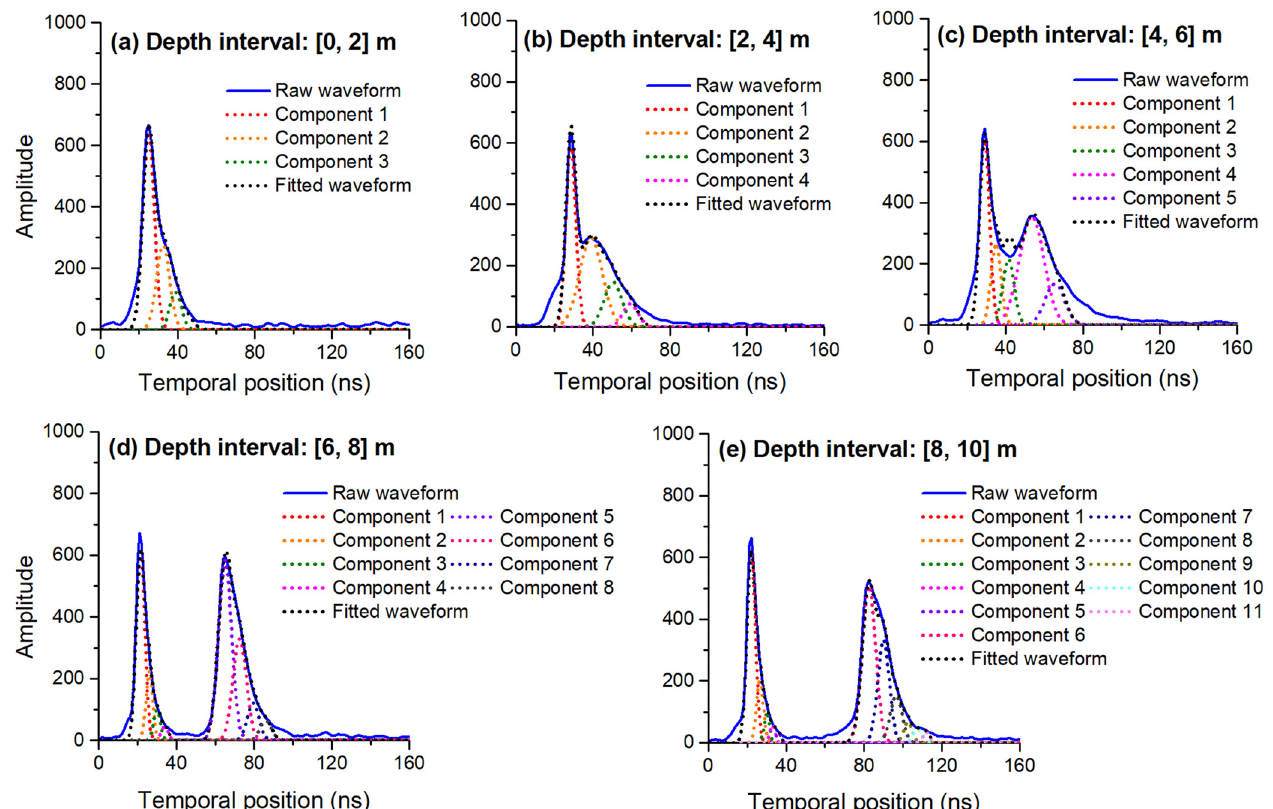
Figure 11. Waveform decomposition diagrams showing waveform components identified using MHGID. The different waveform components are represented by colored dashed lines. The fitted curve reconstructed through the decomposition waveform components is represented by a black dashed line. Table 2. Average numbers of waveform components at various water depths for the two test fields.